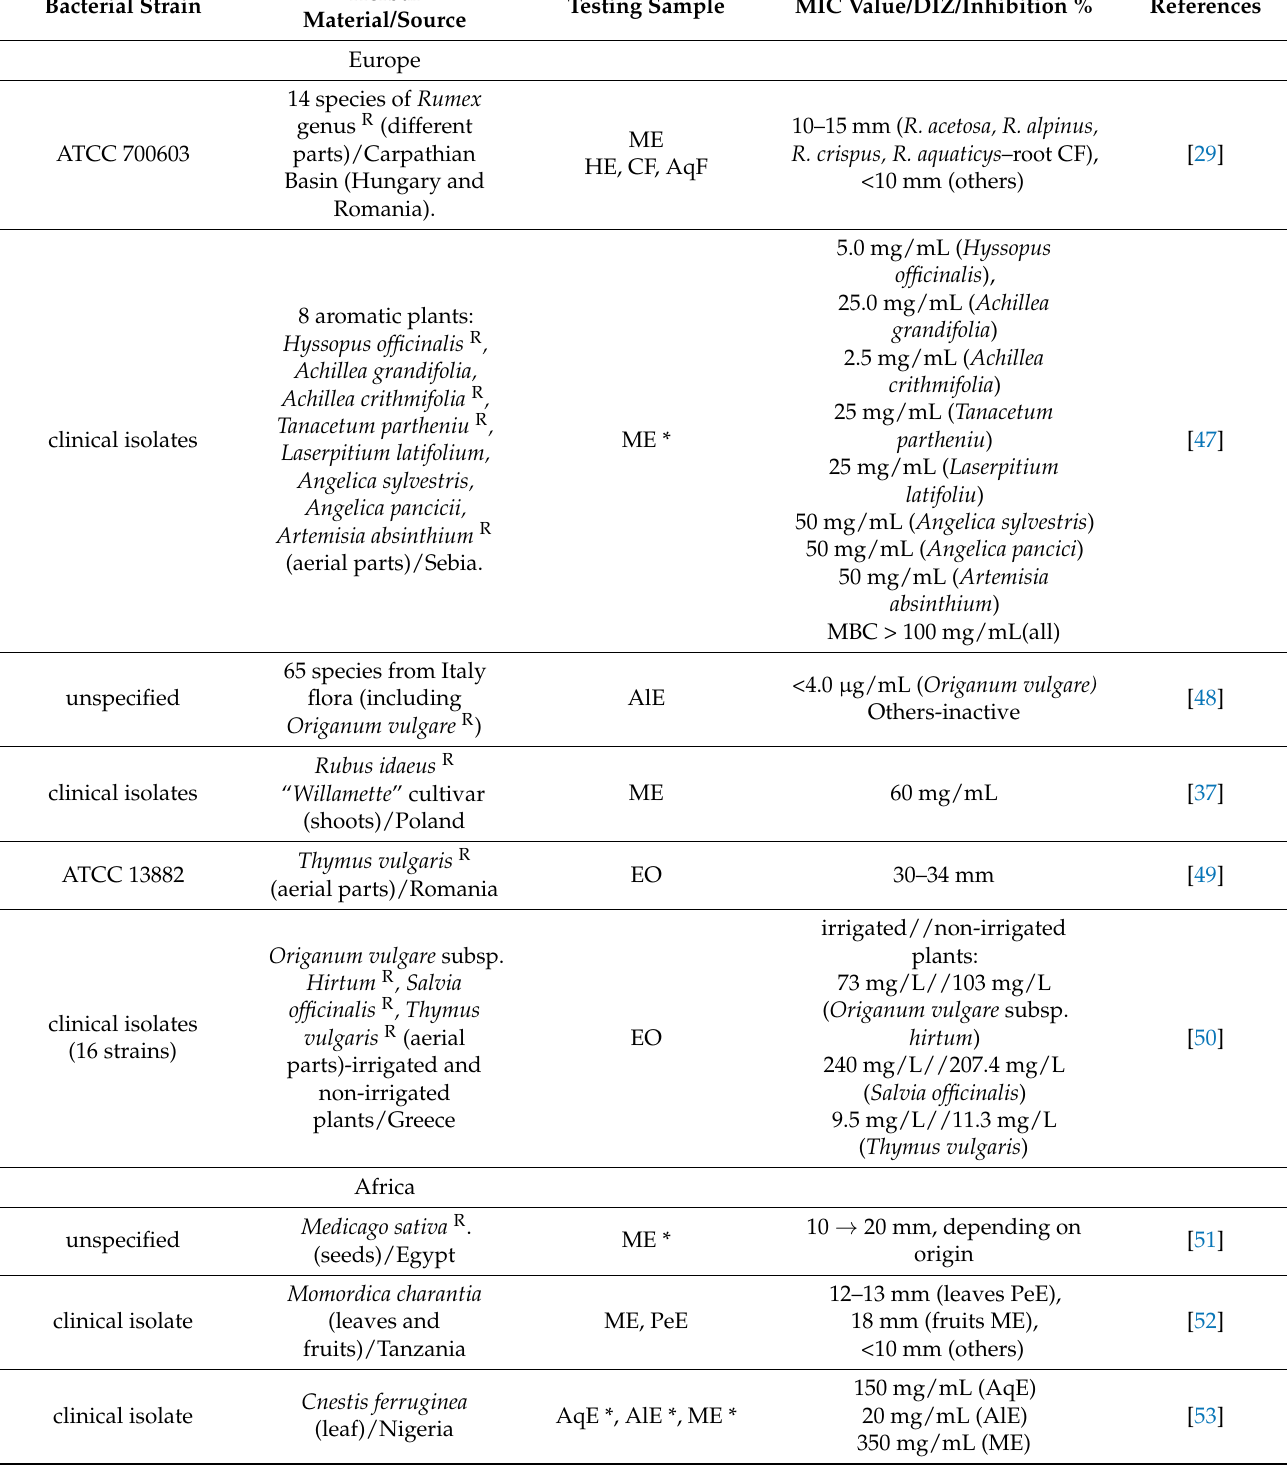
Table 4. Medicinal plants tested for antimicrobial effects against Klebsiella pneumoniae